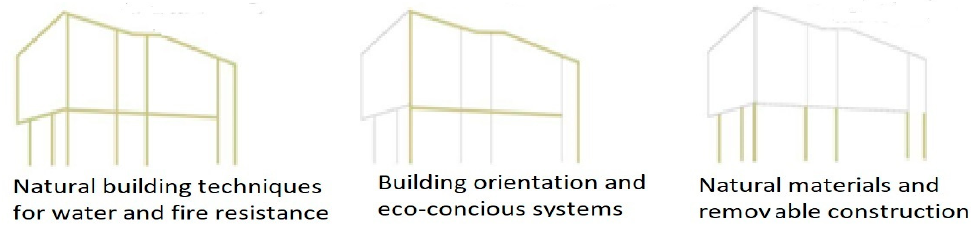
Figure 12. Aspects towards zero impact of Tri Shala on the environment (Source: compiled by the the author).